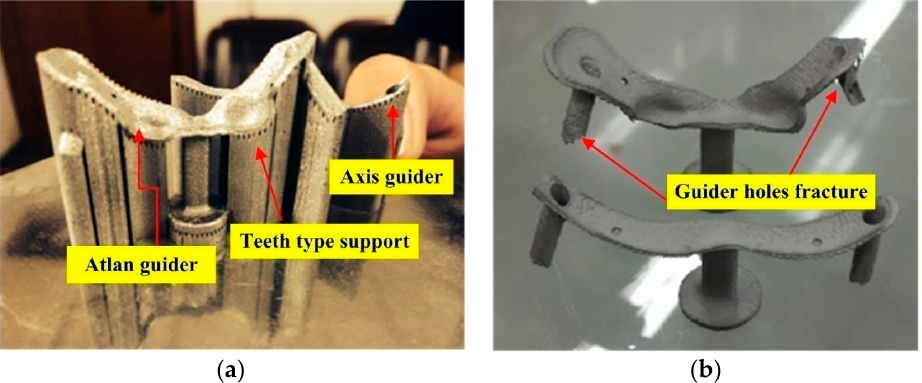
Figure 6. Spinal surgery template obtained from SLM. ( a ) Surgical template without removing the support; and ( b ) surgical template after abrasive blasting.